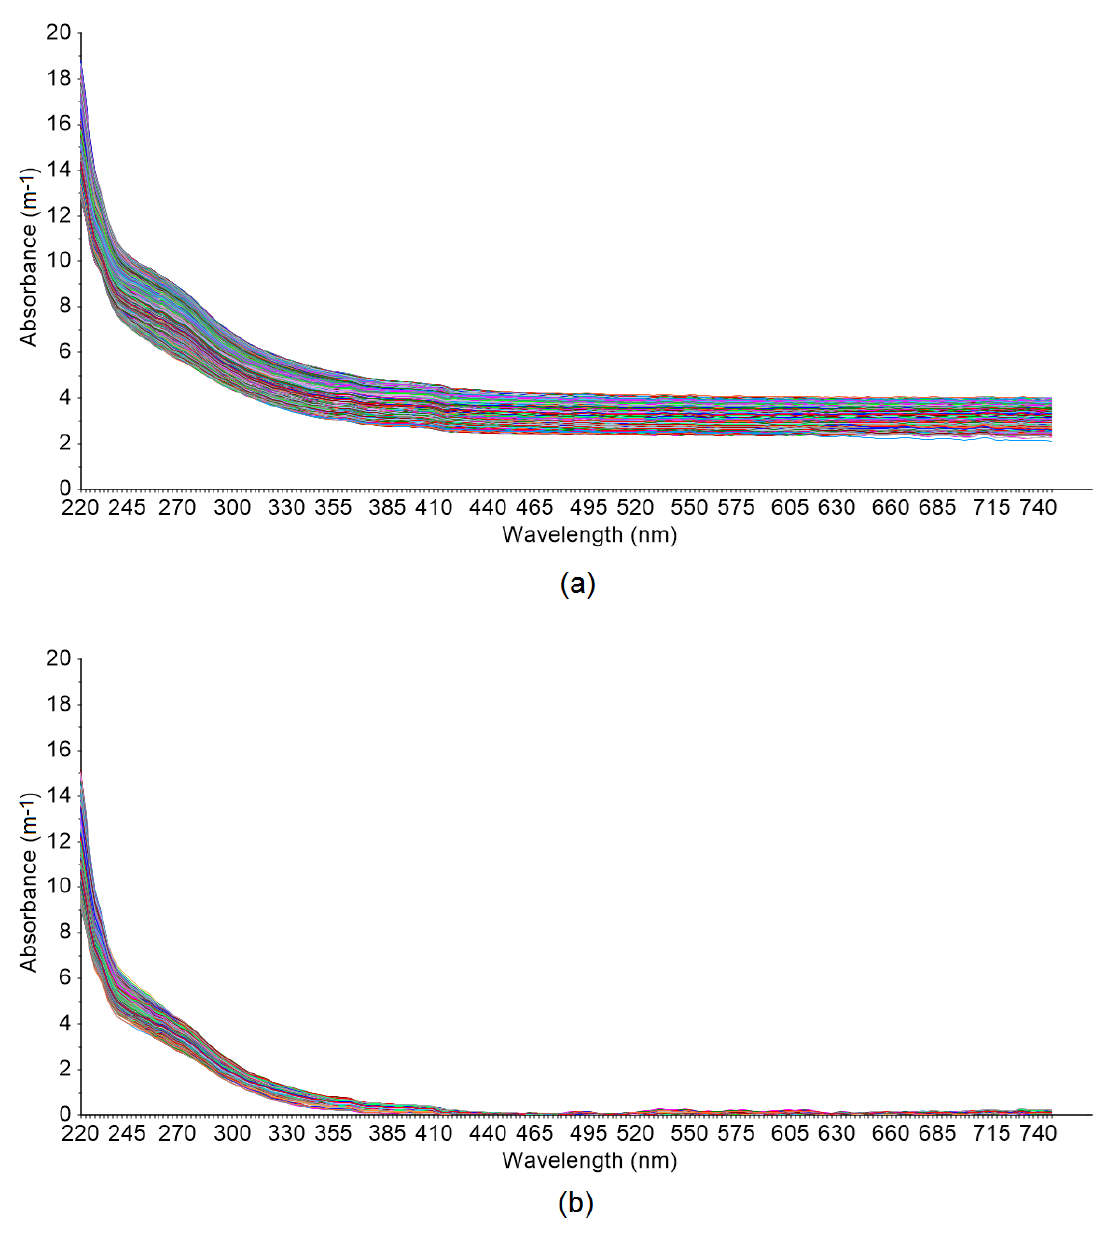
Figure A3. Pre chloramination spectra at the WTP: ( a ) Uncompensated spectra and ( b ) particle compensated spectra (Figure A3b was considered to develop polynomial regression model).